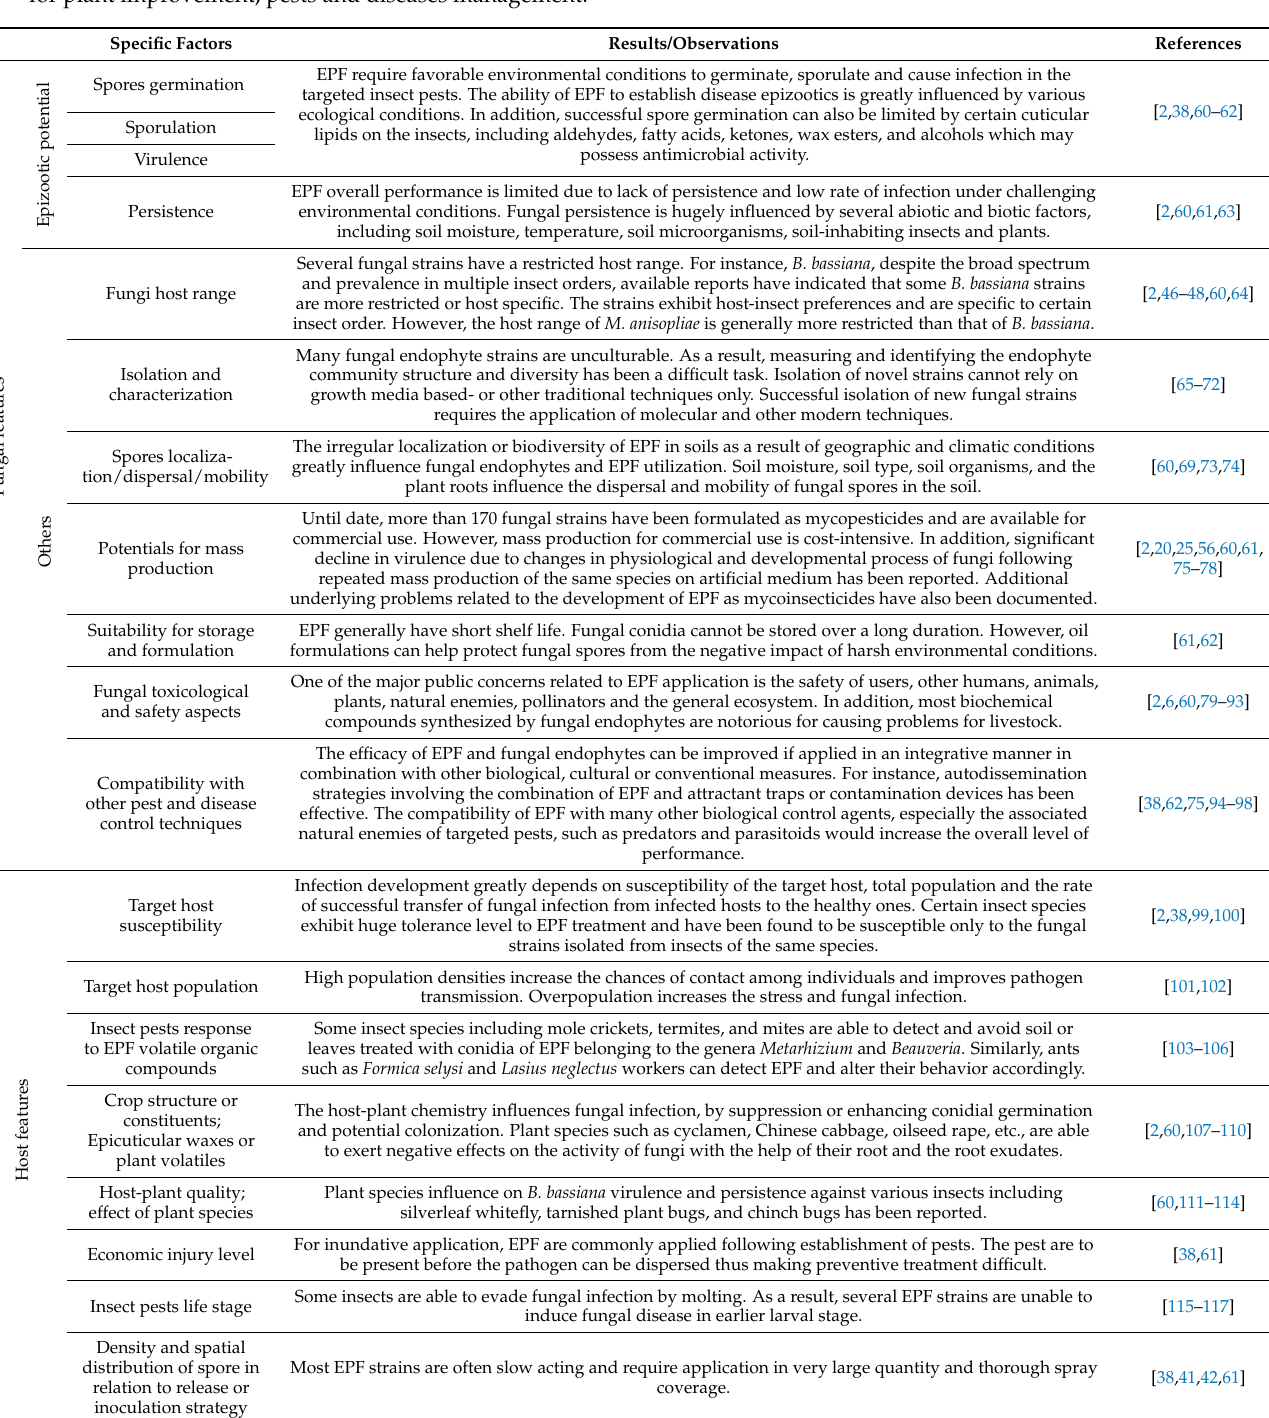
Table 1. Some of the biotic abiotic factors related with isolation, characterization and utilization of EPF/fungal endophytes for plant improvement, pests and diseases